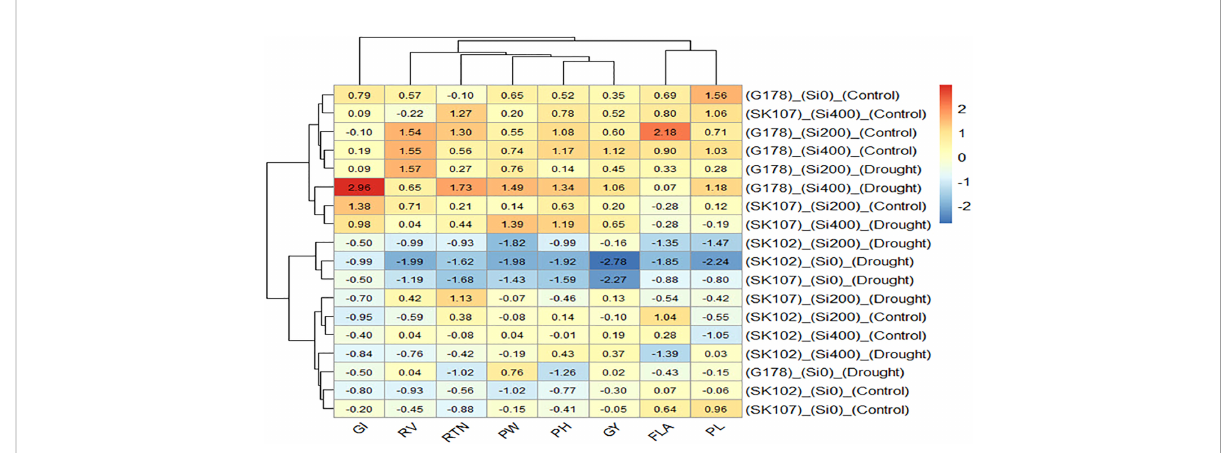
FIGURE 5 Heatmap of the relationship among the treatments and the studied traits. Cells with red color represents elevated values, while cells with blue color represents reduced values of the traits. G178, Giza178; SK102, Sakha102; SK107, Sakha107; GI, grain index; RV, root volume; RTN, reproductive tiller number; PW, panicle weight; HI, harvest index; GY, grain yield; FLA, fl ag leaf area; PL, panicle